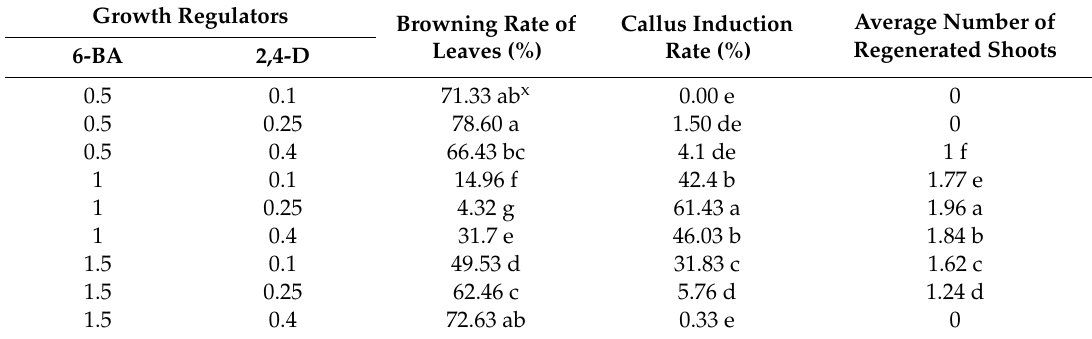
Table 3. Role of 6-benzylaminopurine (6-BA) and 2,4-D hormones combinations in browning rate of leaves, callus induction rate and the average number of regenerated shoots of Jinba.